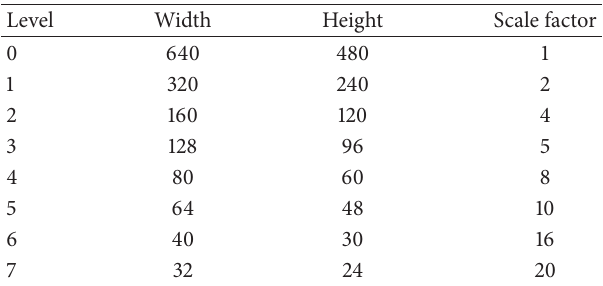
Figure 1: The integral image. Table 1: The scaling factors of the resolutions used by the image pyramids